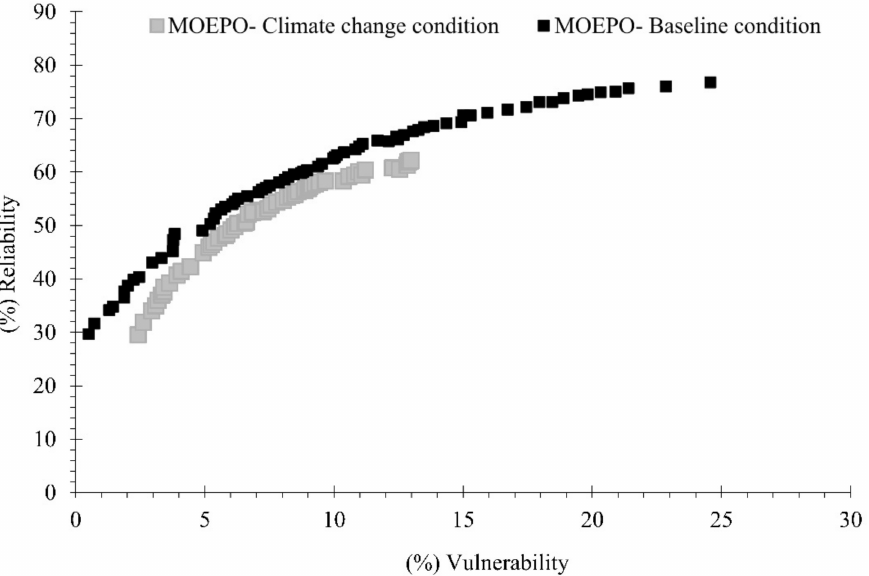
Figure 8. Comparison of the Pareto curve of two objective functions (vulnerability and reliability Indexes) in the baseline and future